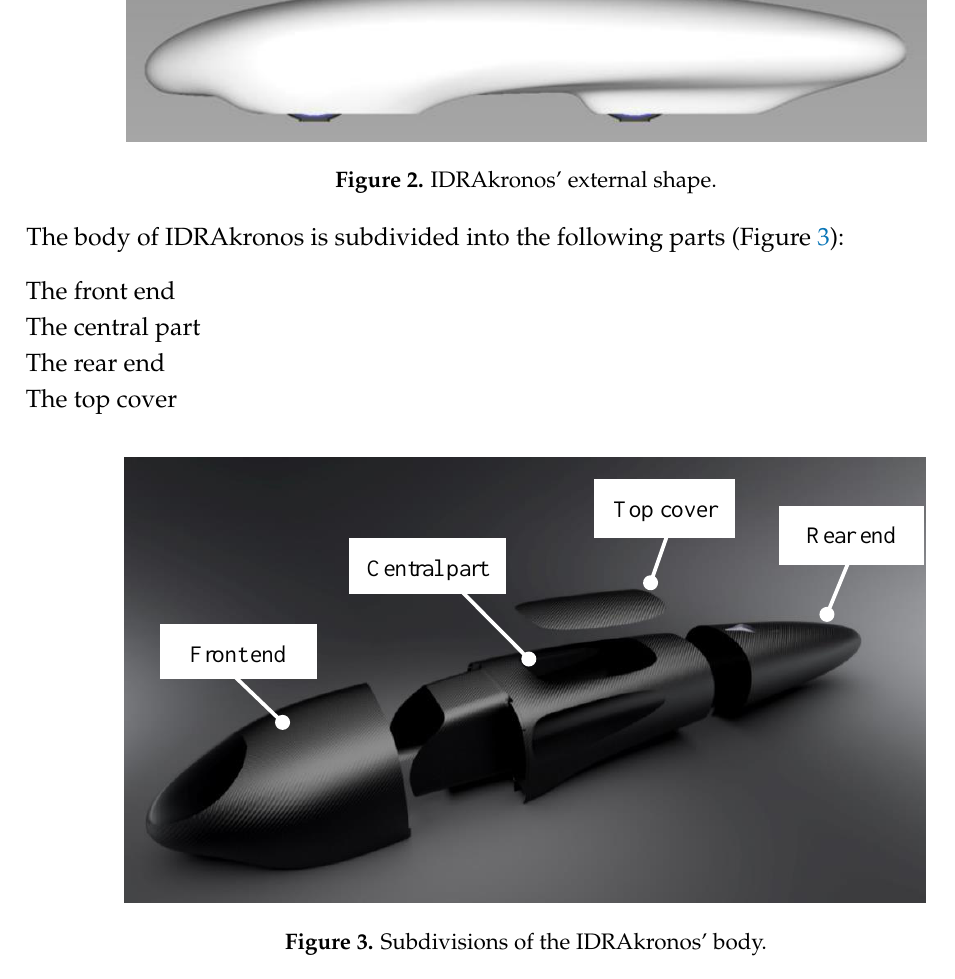
Figure 1. IDRAkronos’ layout.